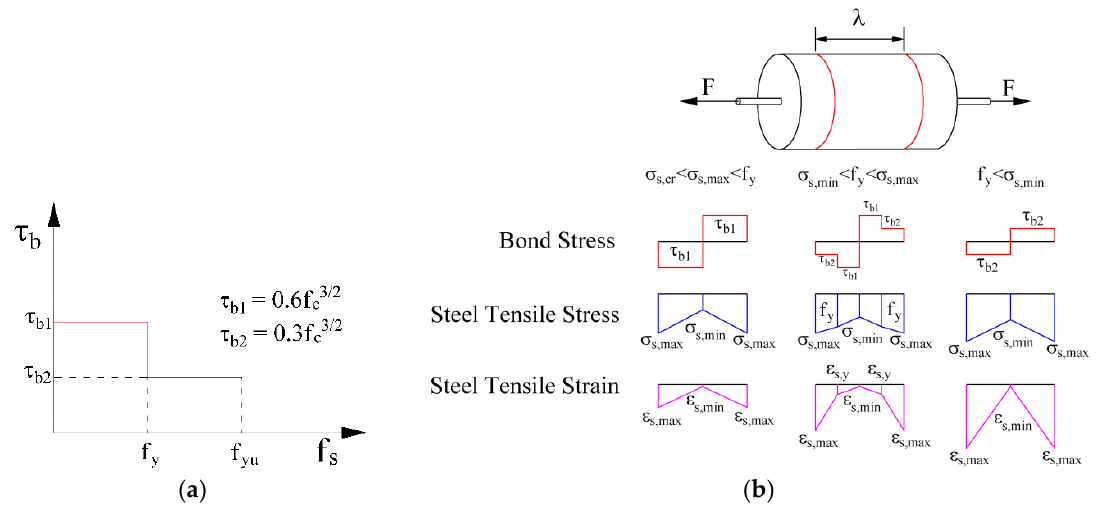
Figure 4. ( a ) Bond–slip relation for the steel–concrete interface; ( b ) adherence, stress, and strain in the